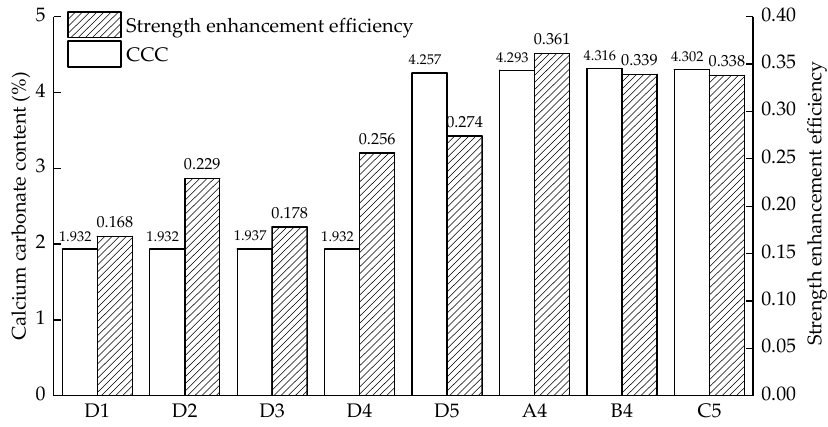
Figure 8. CCC and strength enhancement efficiency of soil treated by different methods.